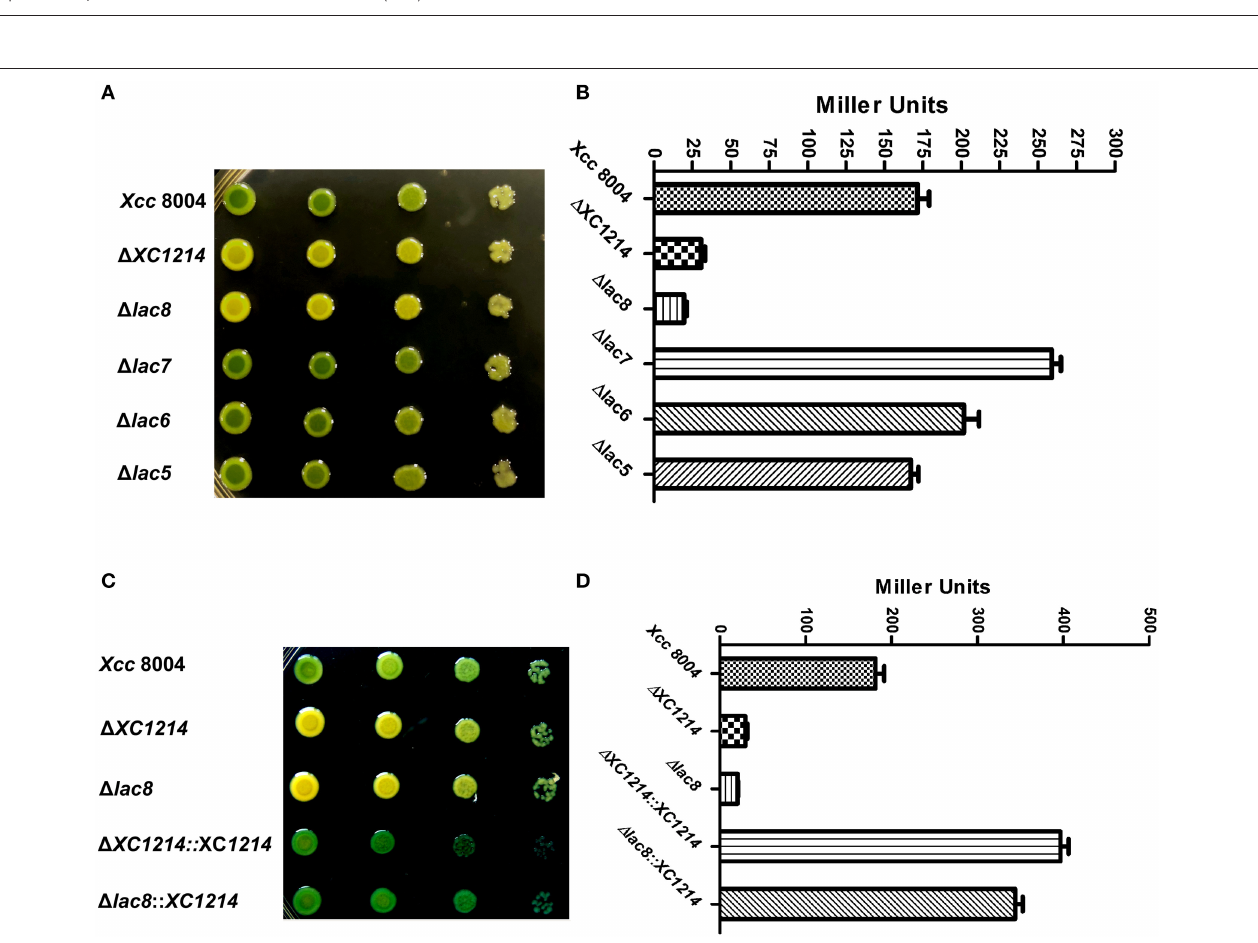
FIGURE 3 | The enzyme activities of GH2 and GH35 proteins in Xcc 8004. Morphology of the GH2 and GH35 deletion mutants (A) on X-gal containing plates and the β -galactosidase activities of these strains (B) . The morphology (C) and β -galactosidase activity (D) of the XC1214 mutant and its complementary strain. Each spot was inoculated with 2 µ l of a 10-fold dilution series (i.e., 10 − 2 -, 10 − 3 -, 10 − 4 -, and 10 − 5 -fold from left to right) from cells in the logarithmic growth phase (OD 600 = 0.8). Triplicate exper i ments were performed , and the means ± SD s were calculated.